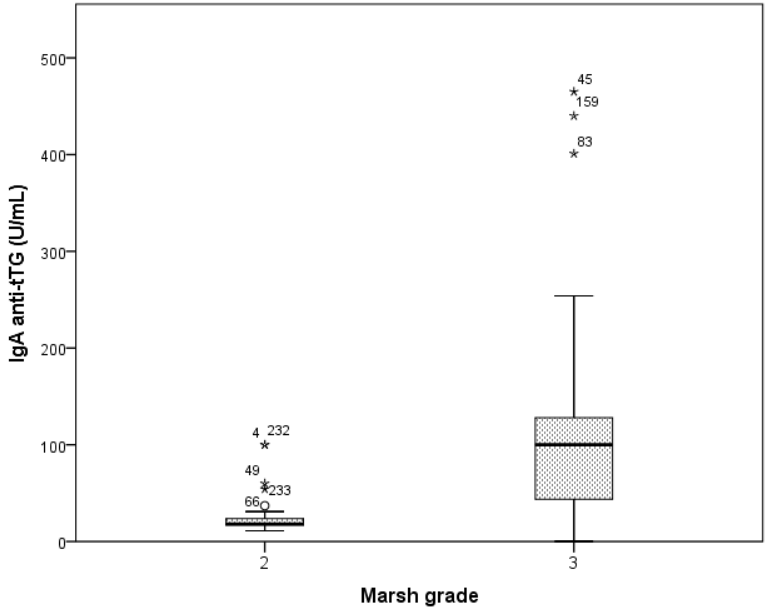
Figure 2. Anti-tissue transglutaminase IgA antibodies levels according to Marsh grade. Abbrevia- tions: IgA, immunoglobulin A; tTG, tissue transglutaminase; UI, International Units; mL, milliliters. * outliers.